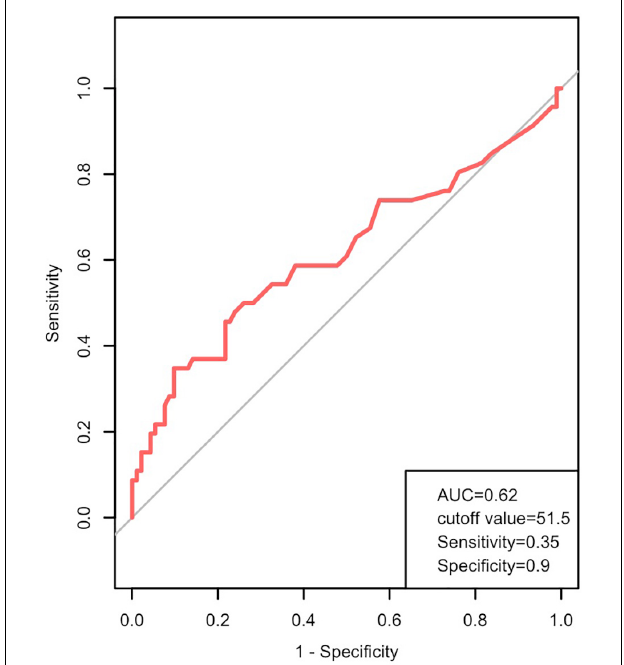
FIGURE 1 | Prognostic value of alanine aminotransferase (ALT) in pediatric patients with DCM. ROC curves showing ALT levels in patients with DCM predicting the cardiac death. AUC, area under the curve; DCM, dilated cardiomyopathy; ROC, receiver operating